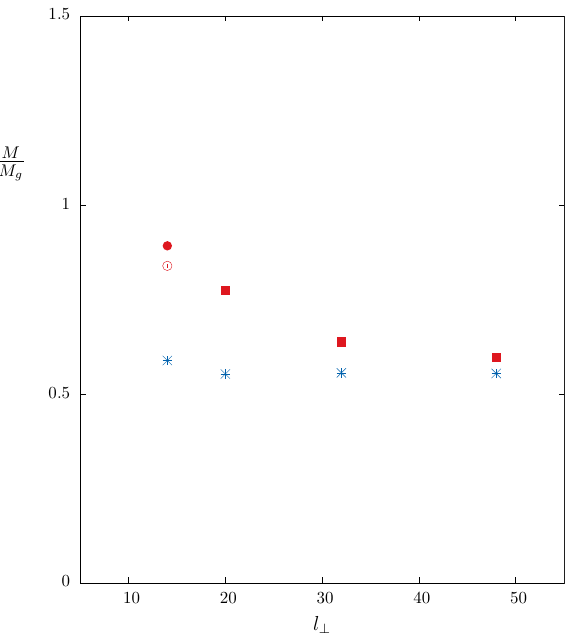
Figure 2 . At (cid:12) = 12 : 0 in SU(2) for our shortest (cid:13)ux tube, l = 14: variation of lightest masses as a function of the transverse spatial size, l ? , in units of the in(cid:12)nite volume mass gap M g . For l ? = 14 the lightest J P = 0 + ( (cid:15) ) and J P = 2 + ( (cid:14) ) masses are shown, and for l ? > 14 we show the mass gap ( (cid:4) ). Also displayed is twice the energy of the winding (cid:13)ux loop ( ?